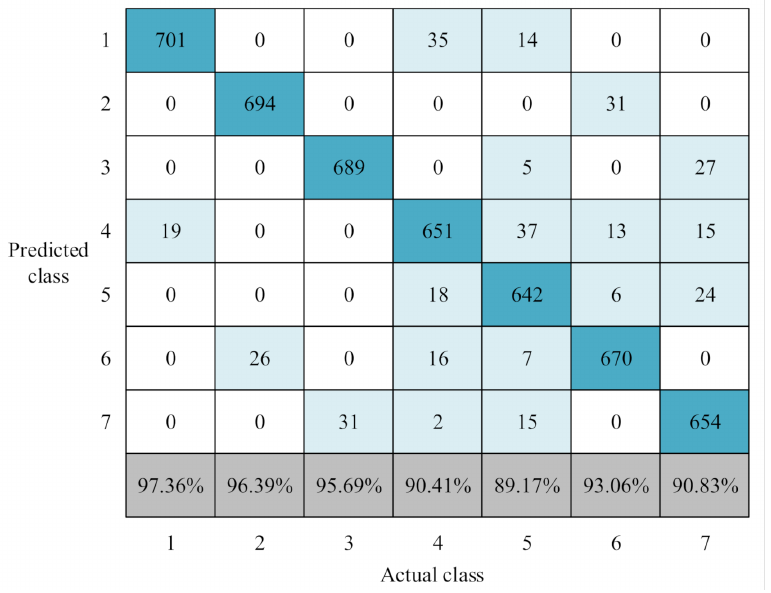
Figure 12. Fault diagnosis result with ideal data based on the Naive Bayesian method. The dark blue box represents the amount of data correctly classified for each